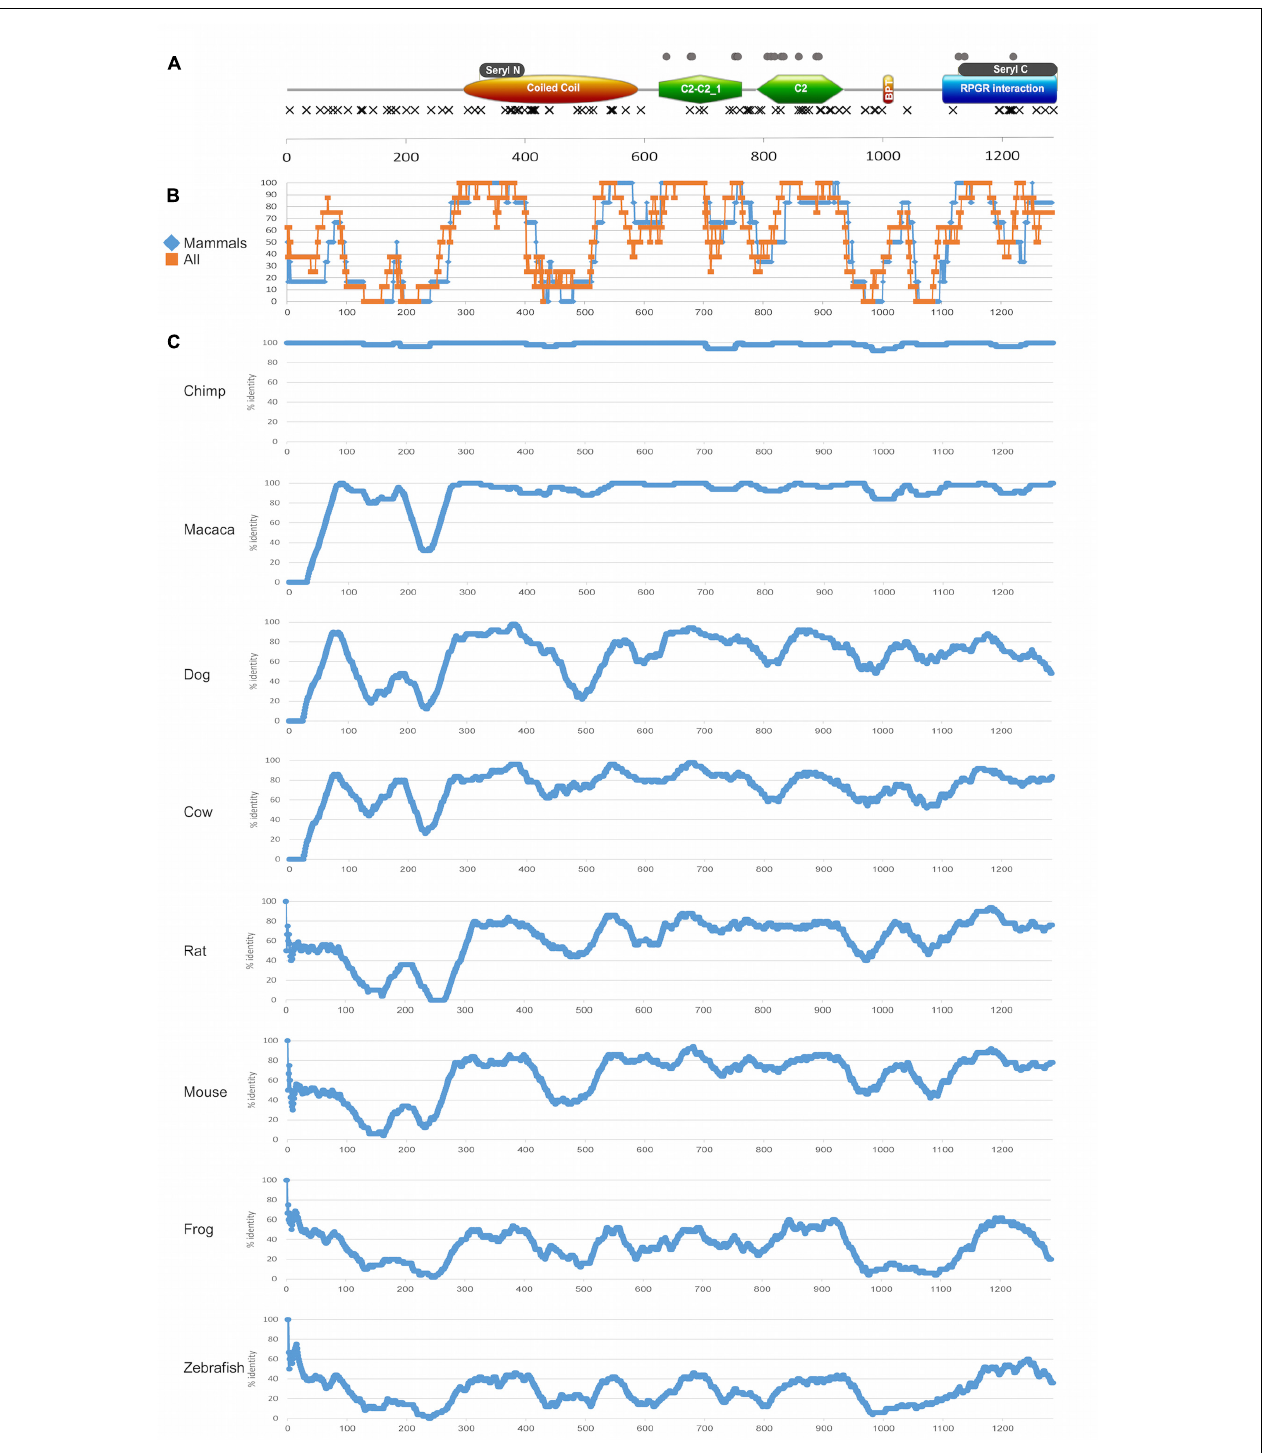
FIGURE 7 | Protein domains and evolutionary analysis of RPGRIP1 . (A) A schematic representation of the RPGRIP1 protein. Orange ellipse represents the coiled coil domain, green polygon represents the C2-C2_1 and C2 domains, orange rectangle represents the bipartite nuclear localization domain, and blue rectangle represents the RPGR-interacting domain. Gray rectangles above the major domains represent the seryl tRNA synthetase N-terminal and C-terminal domains, respectively. Frameshift and nonsense mutations are expected to result in a prematurely truncated protein and are therefore considered as null mutations and marked with black X that are located underneath major domains. Missense mutations are marked with gray circles and are located above the major domains.